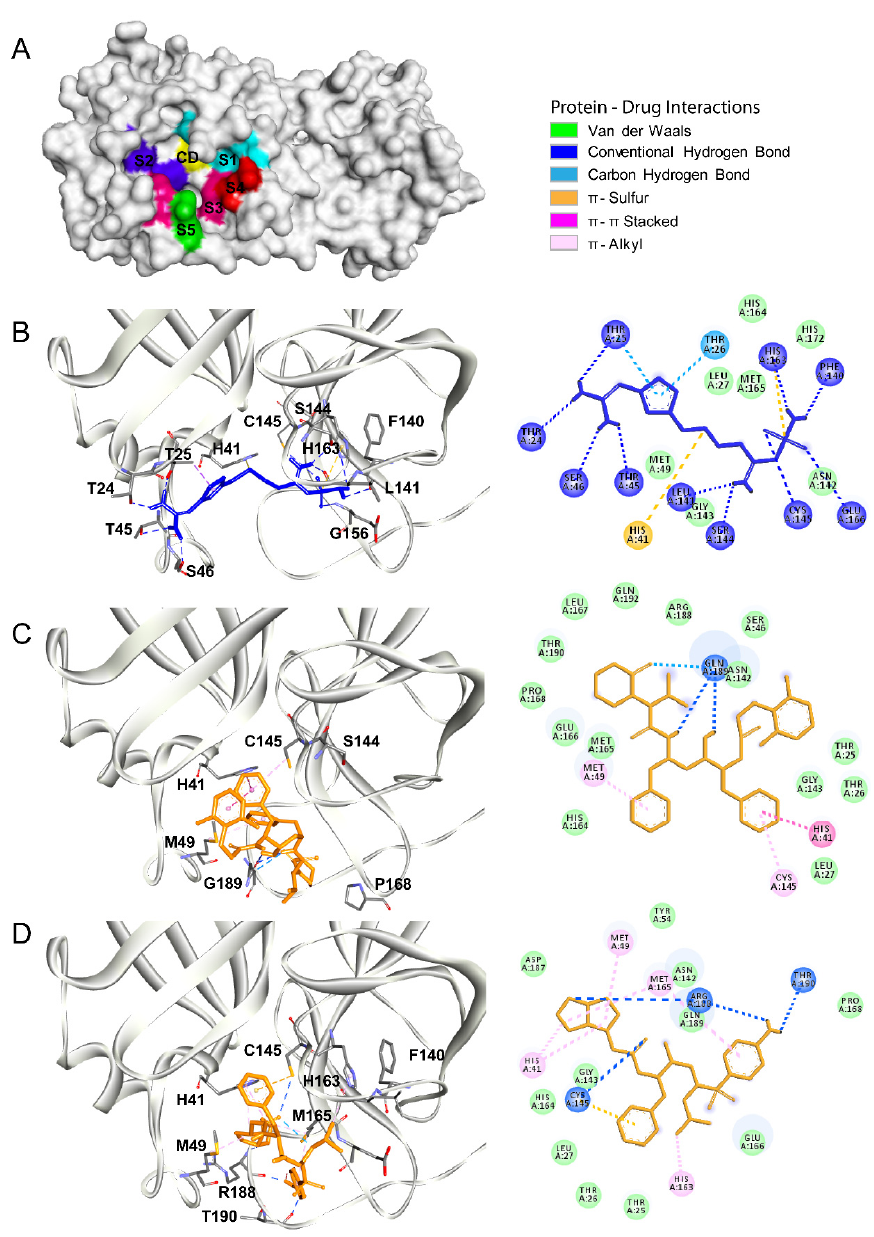
Figure 1. The Severe Acute Respiratory Syndrome Coronavirus type 2 (SARS-CoV2) main protease as a drug target. ( A ) The surface representation of the three-dimensional (3D) structure of the SARS-CoV2 main protease (Protein Data Bank (PDB) identifier (ID): 6LU7). The structural subdomains are indicated with different colors. The catalytic domain (CD) with the His41/Cys145 dyad is shown in yellow. Subdomains S1 (His163, Glu166, Cys145, Gly143, His172, and Phe140), S2 (Cys145, His41, and Thr25), S3 (Met165, Met49, and His41), S4 (Met165 and Glu166), and S5 (Gln189, Met165, and Glu166) are shown in cyan, dark blue, magenta, red, and green, respectively. ( B , C , D ) Molecular docking of famotidine, lopinavir, and darunavir into the catalytic site of the SARS-CoV2 main protease. The 3D structures of the protein–drug complexes are shown on the left. The protein is represented in ribbon, and drug ligands are shown as sticks. Famotidine is shown in dark blue, while lopinavir and darunavir are shown in orange. The main interacting residues are also indicated. The 2D diagrams of the main interaction networks between the drug ligand and the residues within the protease active site are shown on the right. The specific types of interactions are indicated in the legend. The final 3D structures and 2D diagrams of the protein–drug complexes were visualized with the Biovia Discovery Studio Visualizer 17.2.0